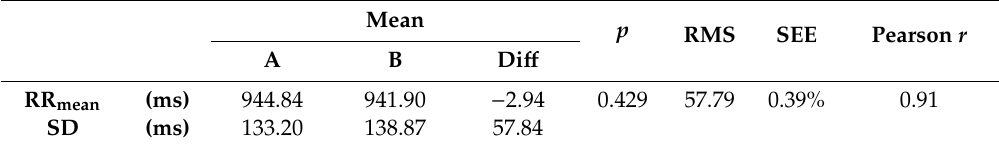
Table 3. Mean values of filtered averaged RR-intervals for measurements using a gel electrode and measurements using the ECG-belt.